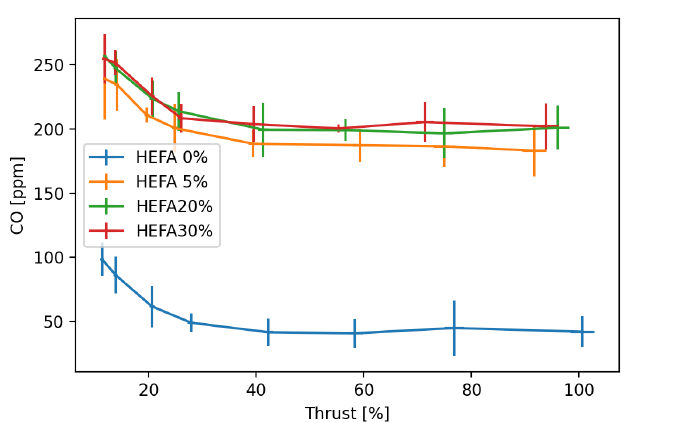
Figure 30. DGEN 380/ATJ: CO 2 .